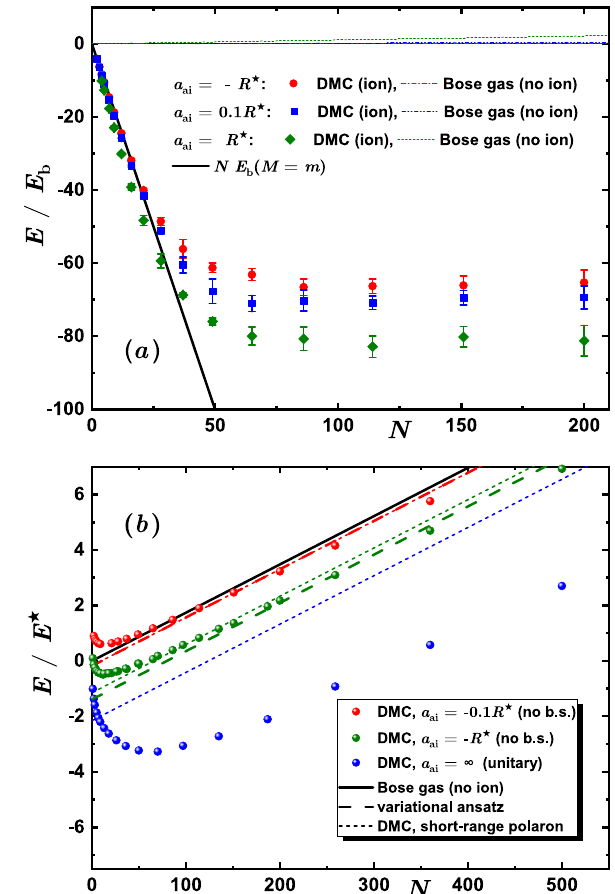
Fig. 2 Ground-state energy of the many-body system. a Total energy obtained as the expectation value of the Hamiltonian (2) in units of the binding energy of the ion – atom molecule E b as a function of the number of bosons N . The symbols represent the energy obtained in diffusion Monte Carlo (DMC) simulations, while the black solid line shows the energy (5). Error bars show the standard deviation of Monte Carlo simulations. b Total energy in units of E ⋆ . For the lines, the mean- fi eld Gross-Pitaevskii energy is shifted by the polaron energy, i.e. E ( N ) = μ pol + gnN /2; solid line, no ion, μ = 0; long-dashed line, variational ansatz 51 , μ pol pol is given by Eq. (6); short-dashed line, diffusion Monte Carlo calculation for short-ranged impurity-boson interactions from ref.